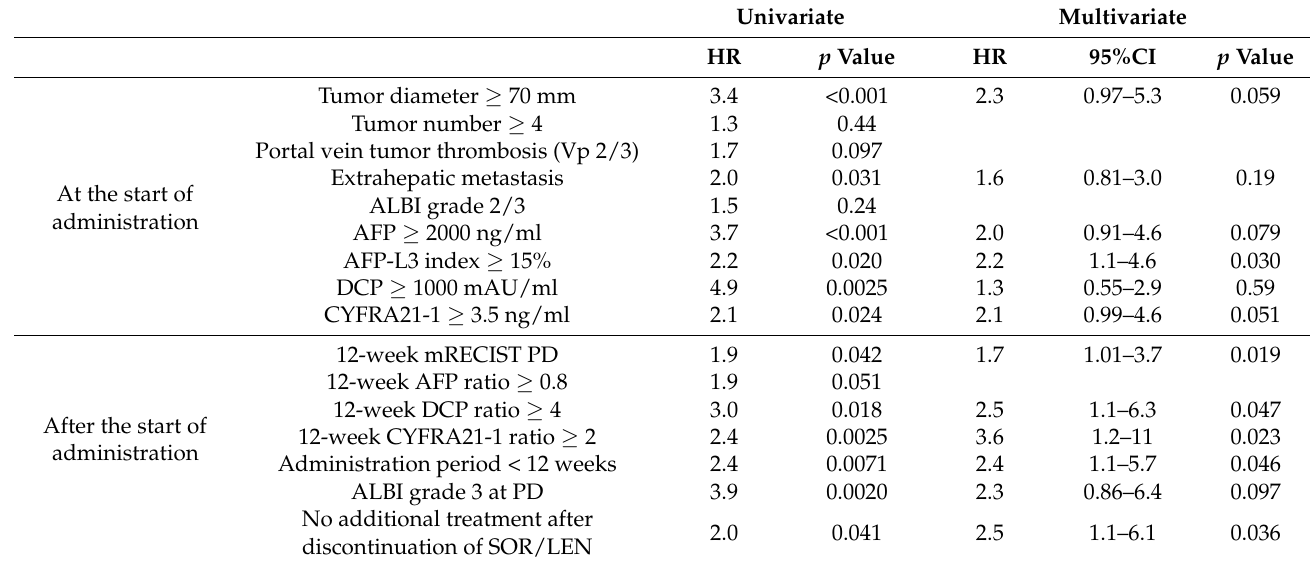
Table 2. Univariable and multivariable Cox proportional hazard model of overall survival in patients taking SOR/LEN.